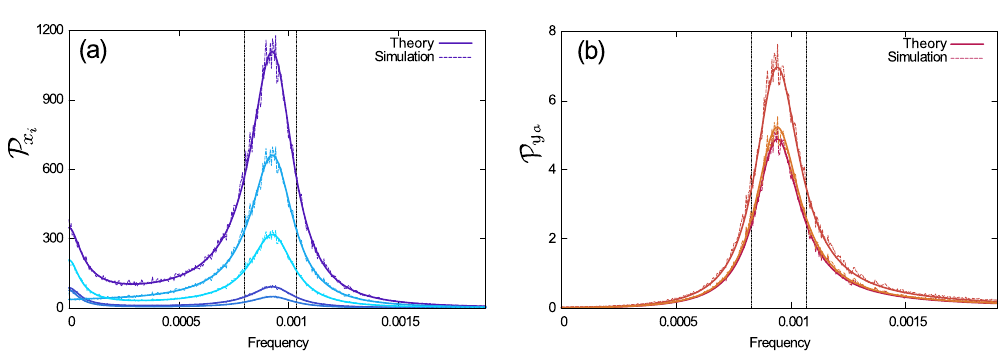
Figure 8. Power spectra of fluctuations for different subclasses of susceptibles and infectives. We use the same χ β as in Fig. 3. Simulations are averaged over multiple realizations of sample of the model parameters p q { , , , } i i a a the stochastic dynamics, at fixed model parameters. The vertical dotted lines are for later purposes and mark the locations at which the power spectra take values approximately equal to half the maximum